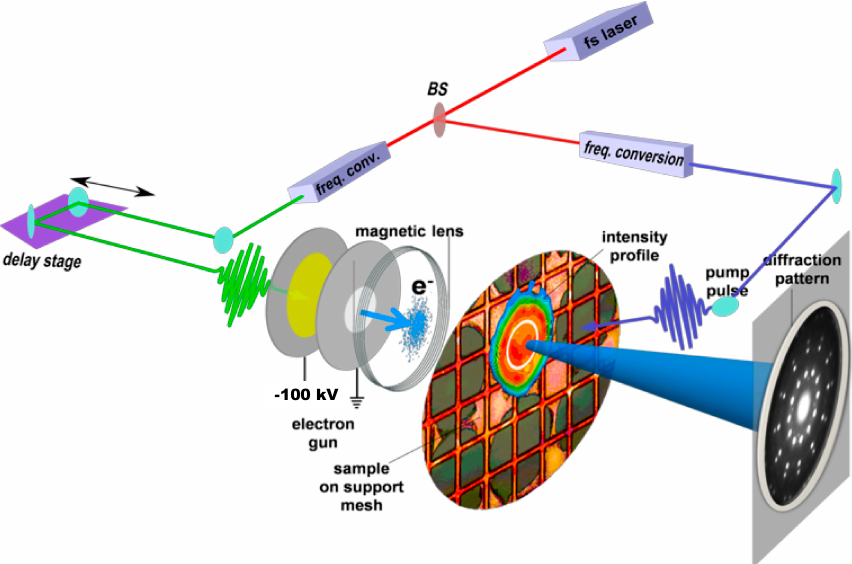
Figure 13. Femtosecond electron diffraction ( FED) layout for a compact electron gun design. In the present compact FED setup, a fs-optical pulse (green) generates, via the photoelectric effect, a fs-electron bunch by back-illuminating an ultrathin ~20-nm thick gold film. Electrons are accelerated by a 100 kV DC potential drop. A magnetic lens can be implemented before or after the sample to focus the diffraction pattern on the detector. Typical electron beam diameters at the sample position range from 50 to 500 µm. Figure adapted from Reference [181] with permission from Science AAAS.